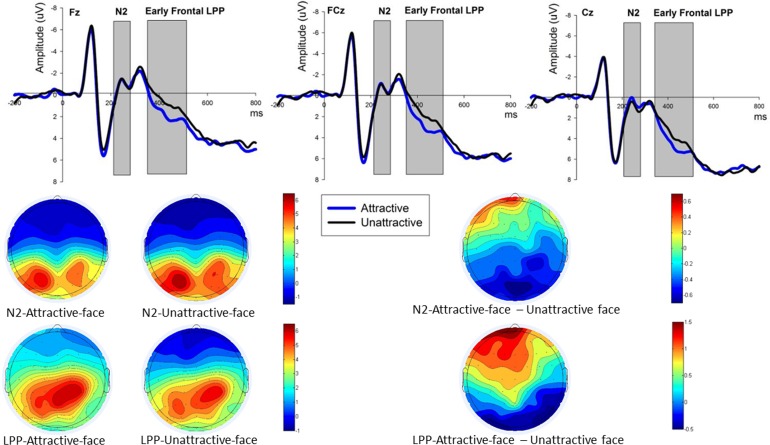
The ERP grand-average waveforms and topographic maps of N2 and early frontal LPP.(A) Fz, FCz and Cz were selected for N2 (shaded 210–280 ms time window) and LPP (shaded 380–480 ms) waveforms to compare among “attractive”, “unattractive” and “attractive minus unattractive” face conditions. (B) The bars for attractive and unattractive faces of the N2, early frontal LPP, N2 difference, LPP difference topographic maps range from -1.5μV to 6.5μV, -1μV to 6.5μV, -0.7μV to 0.7μV and -0.5μV to 1.5μV respectively.